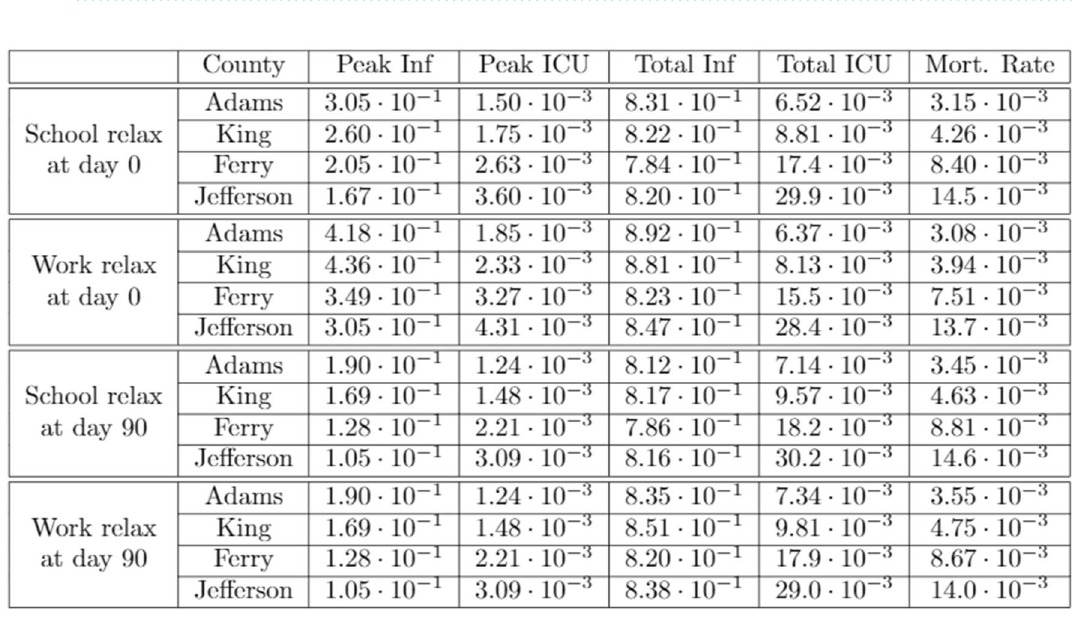
Figure 11. Population affected in relaxing school restrictions .